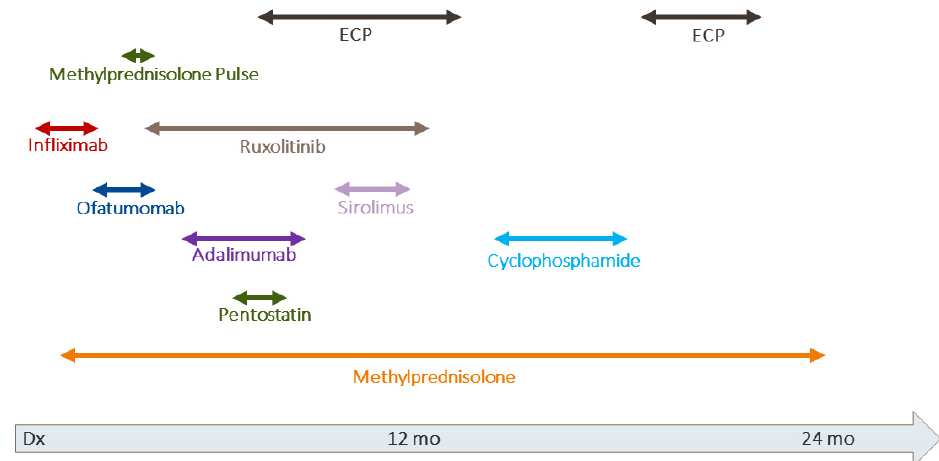
Figure 1. Treatment of cGvHD in case 1. In preparation for stem cell apheresis, a dose of 2 g/m 2 of cyclophosphamide was used for chemomobilization. Ten days after the administration of cyclophosphamide a dose of 15 µg/kg/d of granulocyte colony-stimulating factor (GCSF) was applied for 5 days. Afterwards, the patient underwent one stem cell apheresis with a yield of 2.05 × 10 6 /kg CD34 + cells after immunomagnetic purification using the CliniMacs ® System. These cells were cryopreserved. Due to subjective and minor clinical improvement, we administered three further pulses of cyclophosphamide at a dose of 1.5 g/m 2 at intervals of three weeks. The immune ablation consisted of antithymocyte globulin Grafalon ® (4 × 15 mg/kg), cyclophosphamide (2 × 60 mg/kg) and fludarabine (4 × 40 mg/m 2 ) as depicted in Figure 2. Weekly virus monitoring for HSV, CMV, EBV, and AdV in conjunction with acyclovir prophylaxis and antimycotic preemptive treatment with caspofungin was established. GCSF was administered from day 5 after stem cell rescue. After autologous stem cell rescue with the complete product, the patient showed stable engraftment on day 9 and except for reactivation of cytomegalovirus, no transplant-related complications were encountered. There was a complete response according to the modified NIH criteria for organ scoring except for lung scoring (score 2, which presented as terminal fibrotic lung